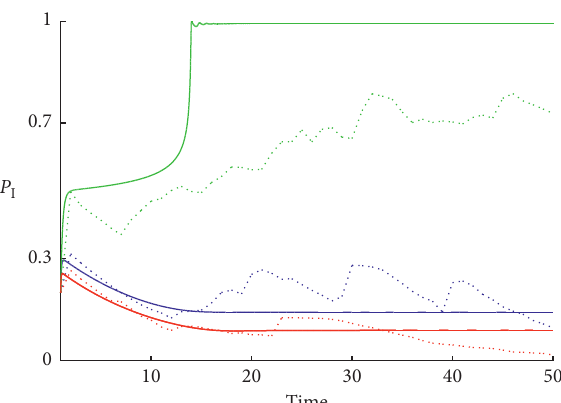
Figure 5: Comparison of the time evolution of prevalence in pairwise model (5) and simulation models, with the continuous curves which are obtained from system (5), and the dotted curves are obtained from average of 50 simulations. The parameter values are c � 0 . 1 , τ � 1 . 5 , n � 10 , ω � 2 . 9 , and β � 0 . 05 (green), 0.1 (blue), or 0.15 (red). The initial value is P I � 0 . 2 , P